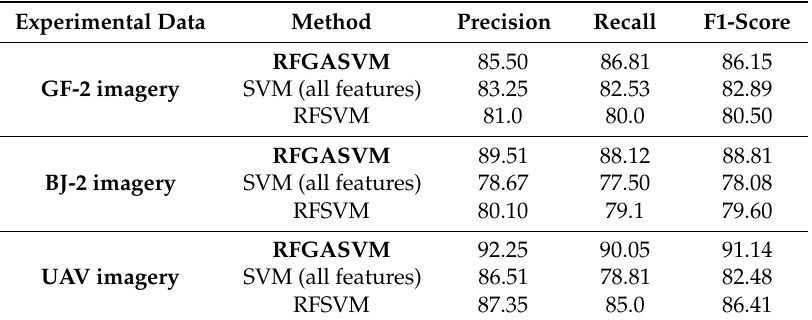
Table 6. Results of the test samples of satellite and UAV imagery between proposed RFGASVM and related methods in terms of precision, recall and F1-score.